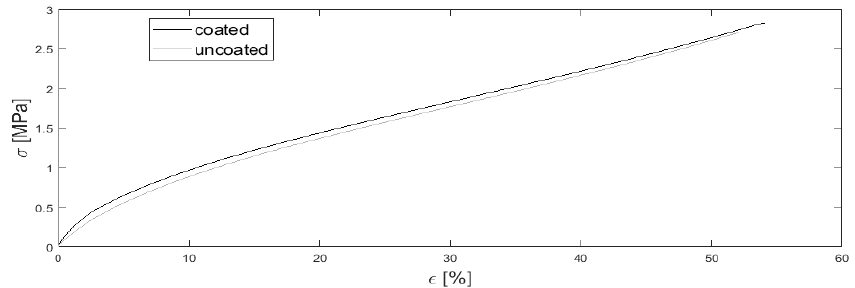
Figure 4. Stress (ε)– s train (σ) diagram of uncoated and DLC coated FKM